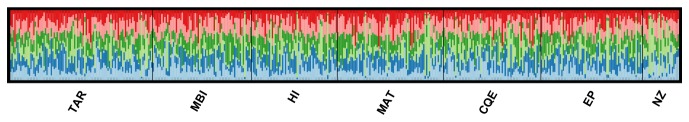
STRUCTURE assignment of individuals across all populations into clusters of best fit at K=6.Colours indicate percentage contribution of individuals to assigned clusters (y axis), individuals represented by each line (x axis), black lines separate populations from which individuals belong. TAR, Taroona Reserve; MBI, Mutton Bird Island; HI, Hobbs Island; MAT, Maatsyuker Island; CQE, Cape Queen Elizabeth; EP, East Pyramids; NZ, New Zealand.